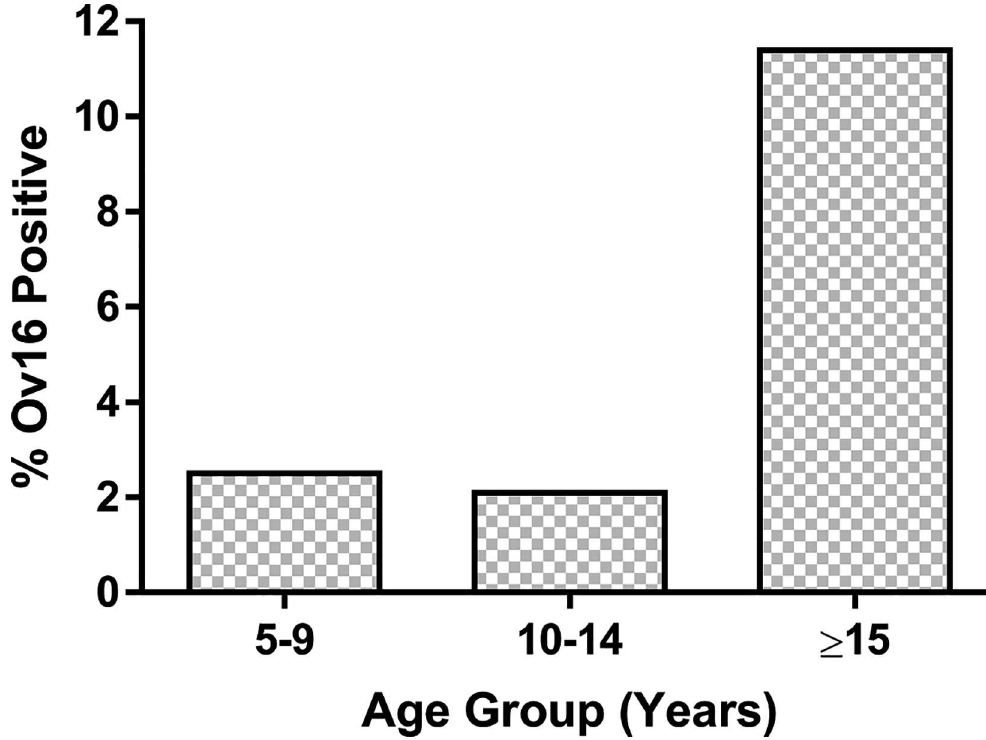
Fig 2. Prevalence of OV-16 Antibodies among study participants by age group